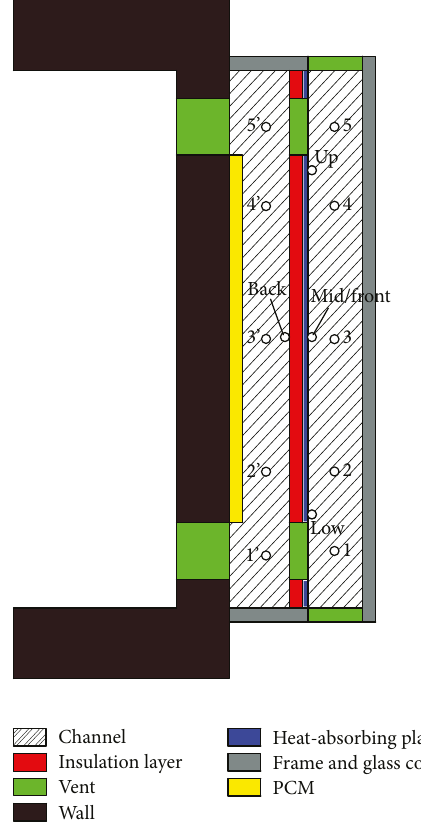
Figure 1: The structural principle of the proposed system and the arrangement diagram of